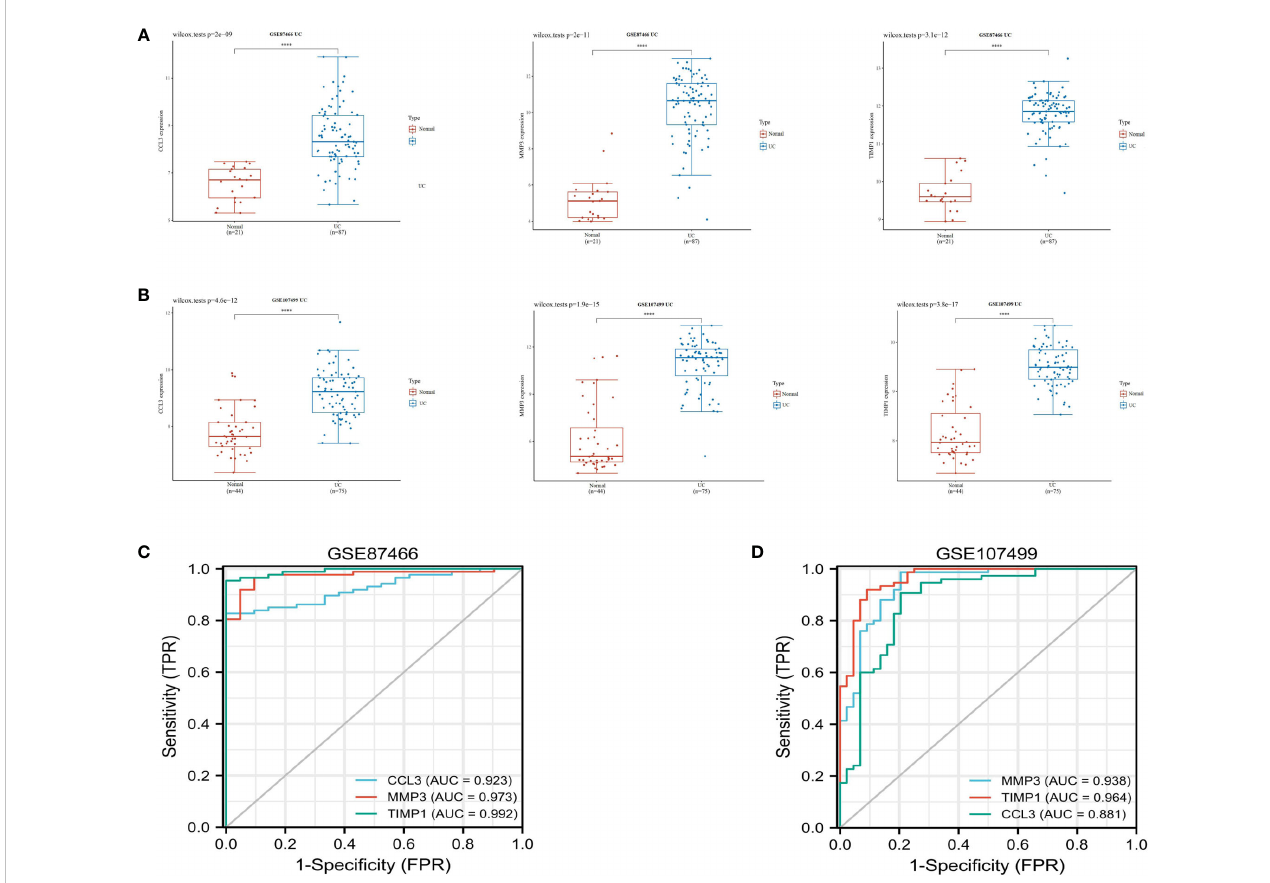
FIGURE 3 Veri fi cation of hub genes. (A, B) The expression of CCL3, MMP3, and TIMP1 in GSE87466 and GSE107499. (C, D) ROC analysis of CCL3, MMP3, and TIMP1 in the GSE87466 and GSE107499 datasets. "****" corresponds to 0.01% signi fi cant level, that is, p<0.0001, p<0.0001, which indicates that the difference is 99.99% certain, and the difference is very signi fi cant, with statistical signi fi